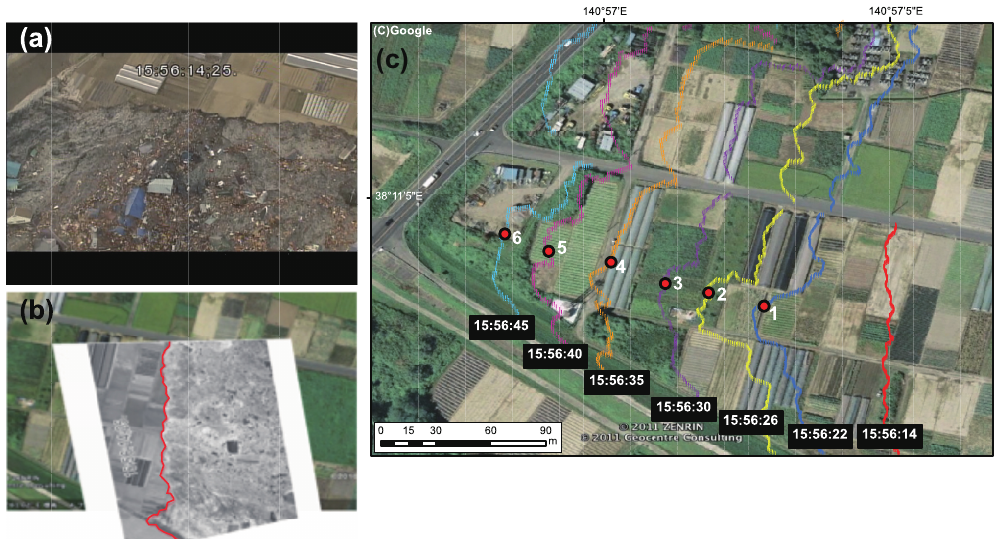
Figure 2. Sequence of tsunami inland penetration observed on the Sendai coast on 11 March 2011 [10,11]. ( a ) A video frame extracted from the original NHK’s video at 15:56:14 (Hours:Minutes:Seconds, 11 March 2011, JST). ( b ) A tsunami front line (red line) as a result of projective transformation of the captured video frame. ( c ) Result of mapping tsunami front